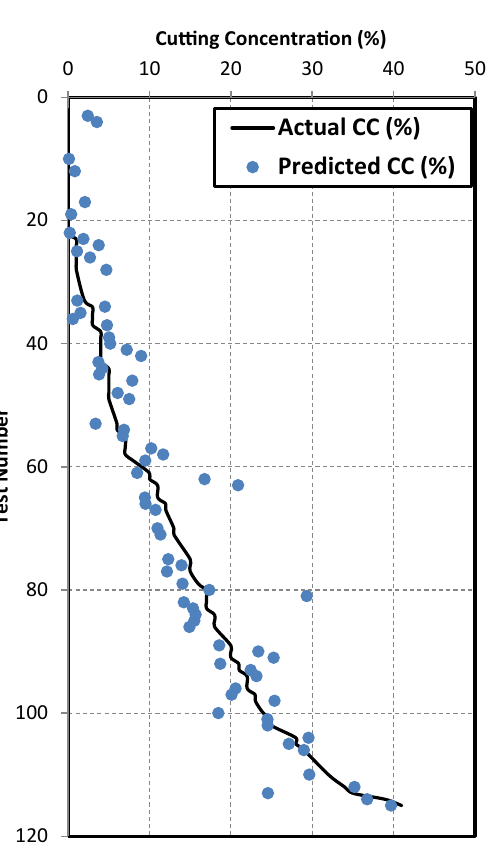
Fig. 9 Actual (experimental) and RBFN-predicted cutting concentra- tion versus test number from training